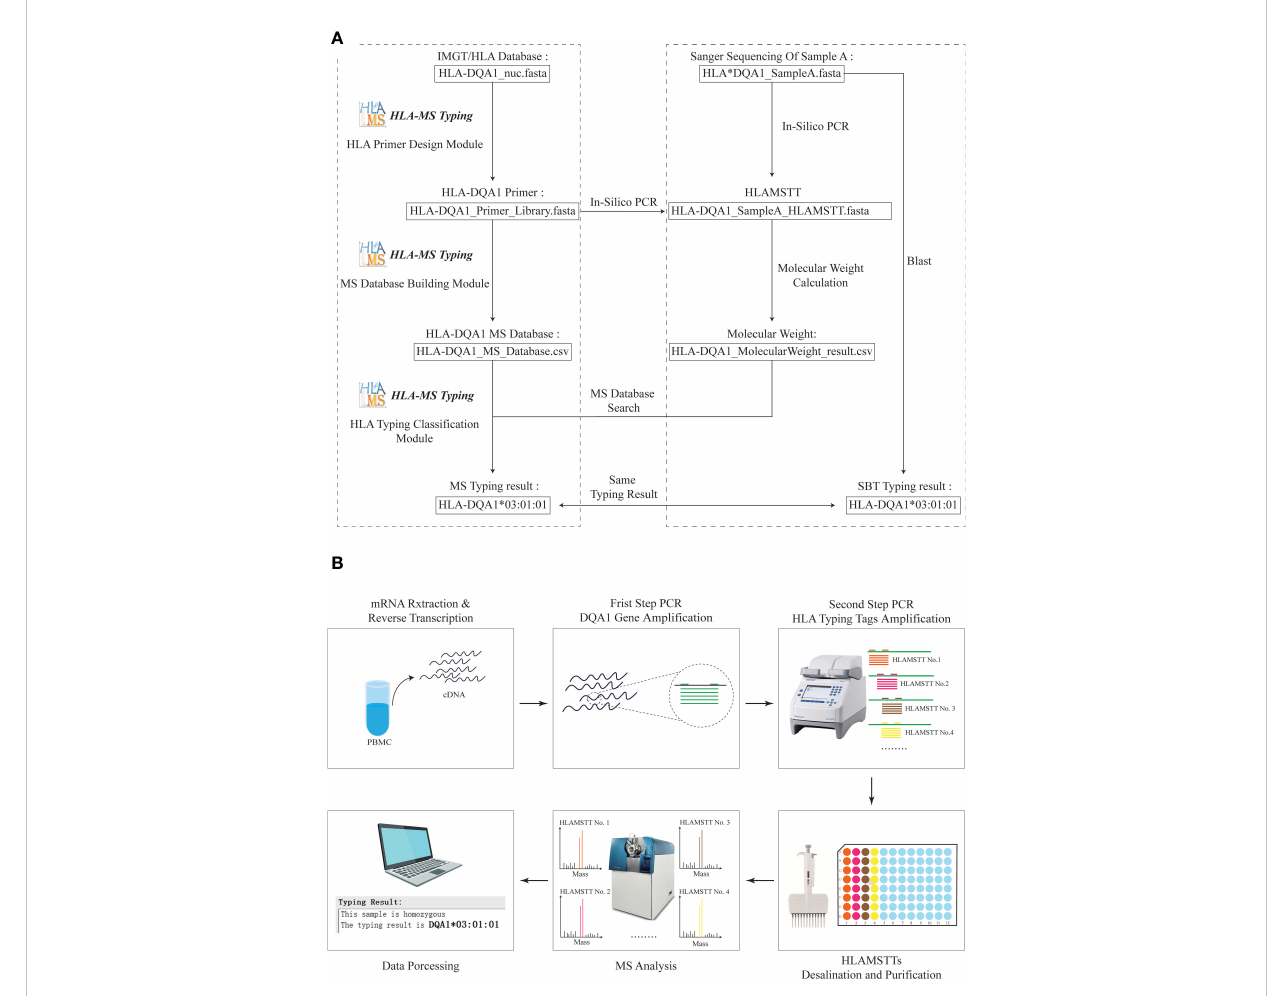
FIGURE 3 Practical application of HLA MS typing in silico and wet validation. (A) HLA MS typing in silico validation with HLA-DQA1. For HLA samples with known Sanger sequencing results, SBT and HLA MS typing were used simultaneously for in silico typing, and the same typing results were obtained; HLA-DQA1*03:01:01. (B) HLA-DQA1 MS typing using wet laboratory techniques. For an untyped HLA-DQA1 sample, the following process was performed: mRNA extraction and reverse transcription, DQA1 gene ampli fi cation, HLAMSTT ampli fi cation, MS typing, and data processing; the typing result was